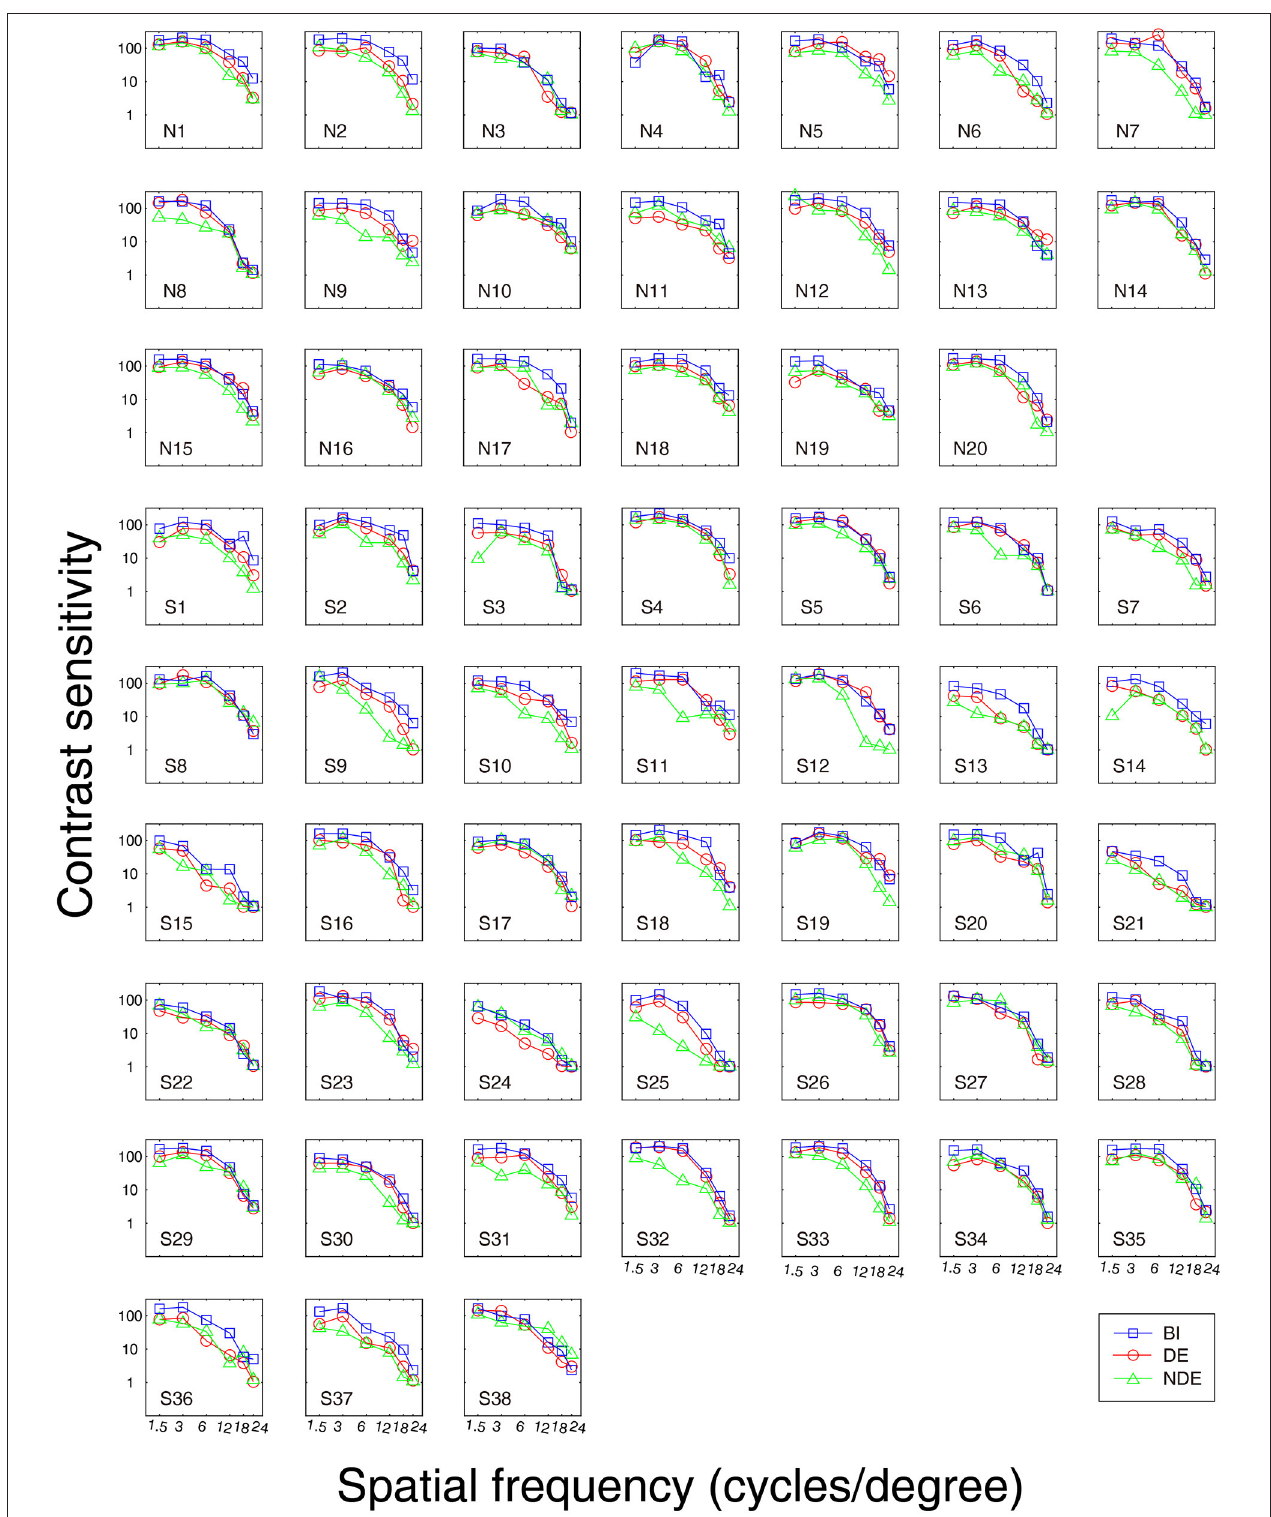
FIGURE 2 | Contrast sensitivity curve for each subject. S1-S21, IXT surgically corrected patients with good alignment; S22-S38, IXT surgically corrected patients with recurrence; N1-N20, Normal Controls; BI, binocular; DE, dominant eye; NDE, non-dominant eye.